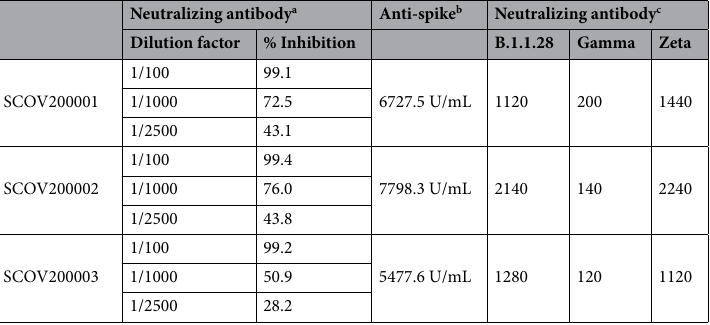
Table 1. Equine Anti-SARS-CoV-2 F(ab ′ ) 2 immunoglobulin potency. a cPass Neutralization Antibody Detection kit (GenScript #L00847). b Elecsys ® Anti-SARS-CoV-2 S (Roche # 09289267190). c VNT-CPE assay using B.1.1.28. Gamma and Zeta